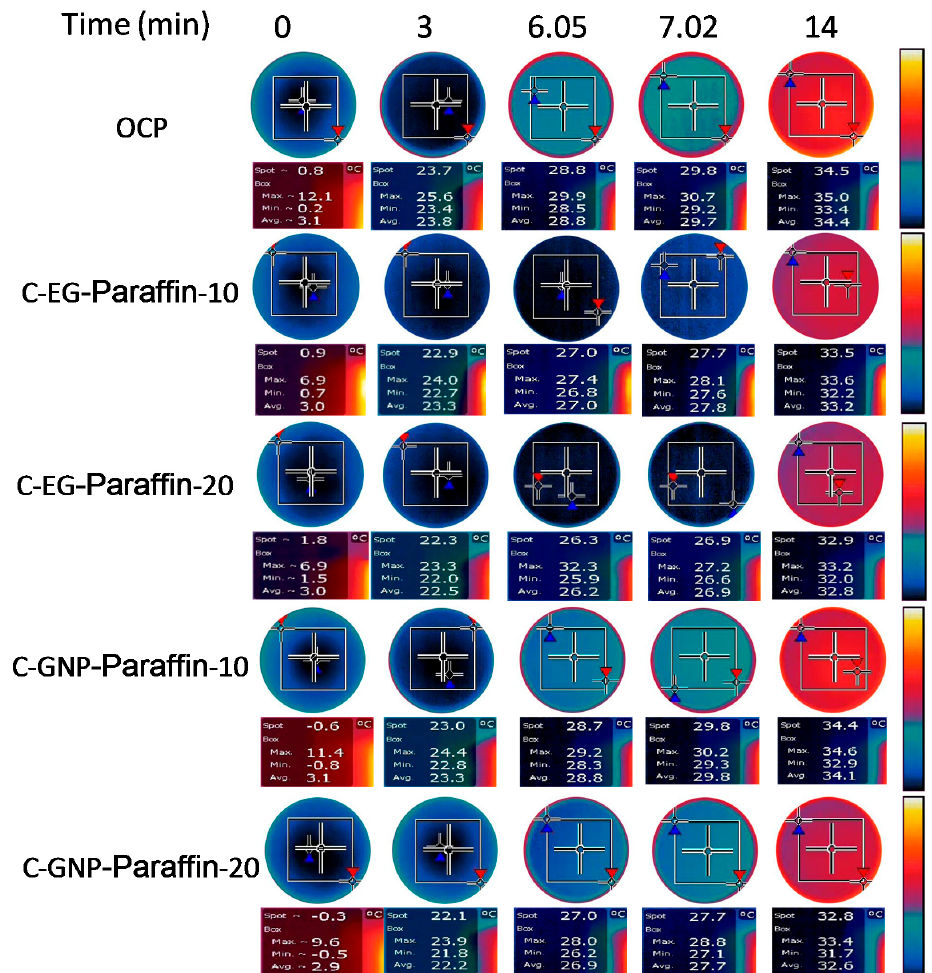
Figure 5. Infrared thermograph images of the cement paste disks with and without CPCMs heated for different time periods. The maximum, minimum, and average temperatures and the temperatures at the marked point (Spot) are presented under each thermal image.